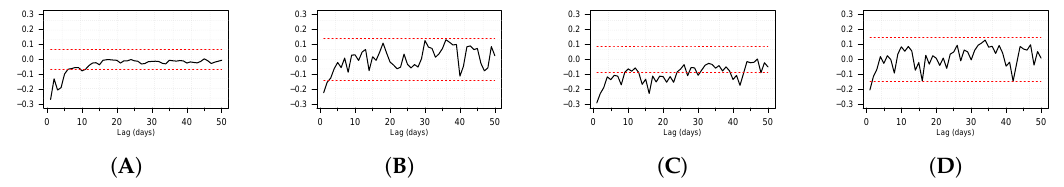
Figure 7. Empirical cross correlation at different lags between realized variance and the leverage ) for h = 1, . . . ,50. Panels ( A ) and ( B ) report results for Bitstamp over the full component, cor ( RV t , r − d t − h sample and the Hype period, respectively. Panels ( C ) and ( D ) report results for Coinbase over the full sample and the Hype period, respectively. Horizontal red dashed lines indicate 95% confidence